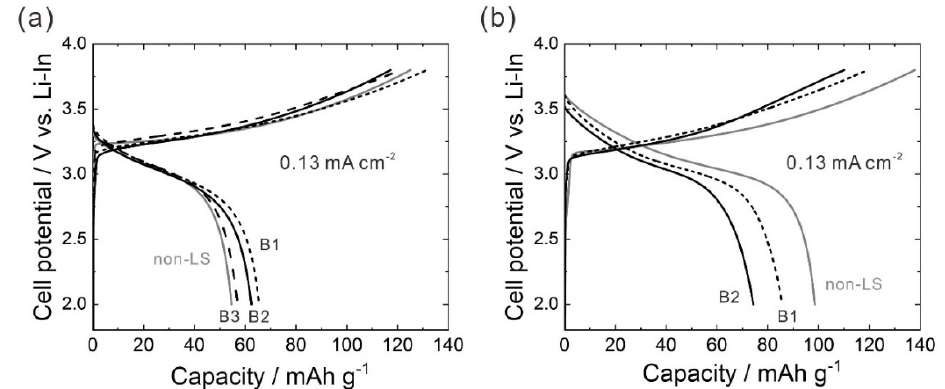
Figure 4. First charge–discharge curves of the all-solid-state cells using composite electrodes with 80Li2S ∙ 20P2S5 solid electrolytes prepared via ( a ) simple mixture and ( b ) solution processes at 2.0 to